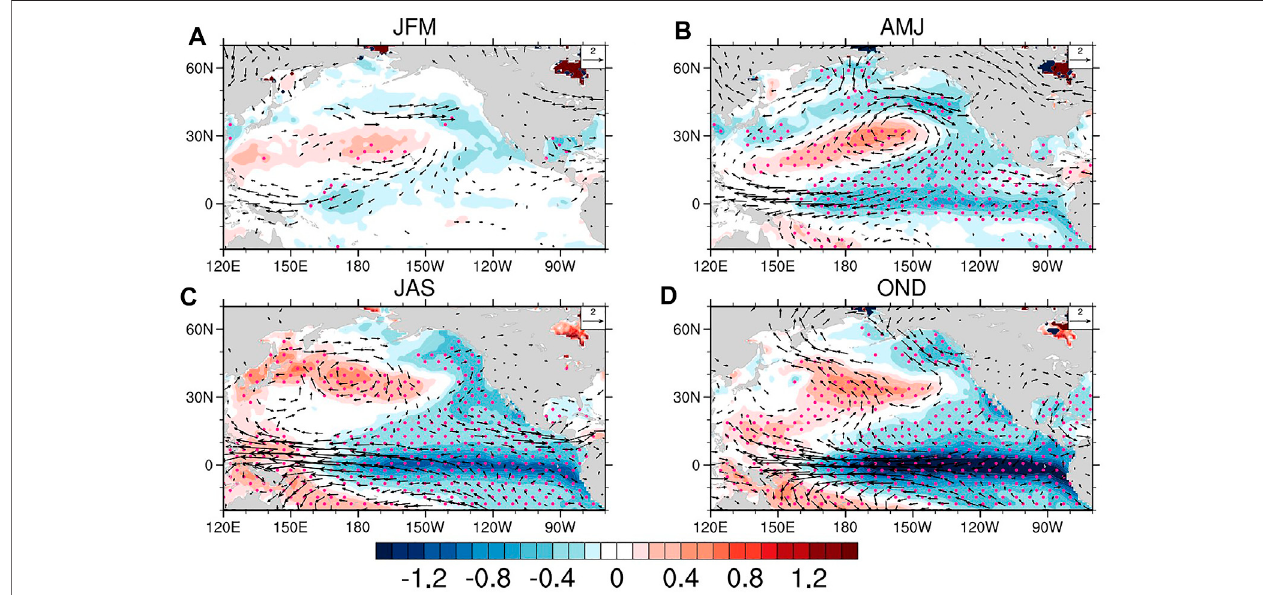
FIGURE 4 | Composite SST ( ° C) and 850-hPa winds (vectors; m s − 1 ) in the La Niña years with enhanced SH and El Niño years with suppressed SH (multiply by a factor of -1) during (A) January-February-March (JFM), (B) April-May-June (AMJ), (C) July-August-September (JAS) and (D) October-November-December (OND). Stippled regions indicate anomalies signi fi cant at the 90% con fi dence level. Only wind anomalies signi fi cant at the 90% con fi dence level are